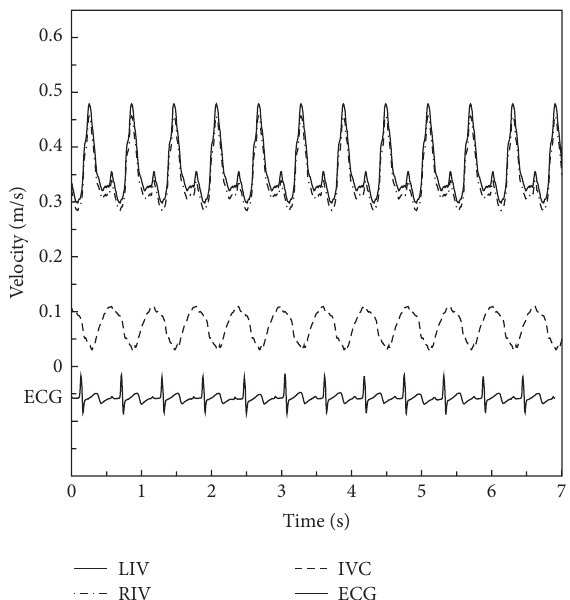
Figure 3: Velocity data as inlet boundary conditions only including cardiac pulsatility (IVC: inferior vena cava; LIV: left innominate vein; RIV: right innominate vein; ECG: